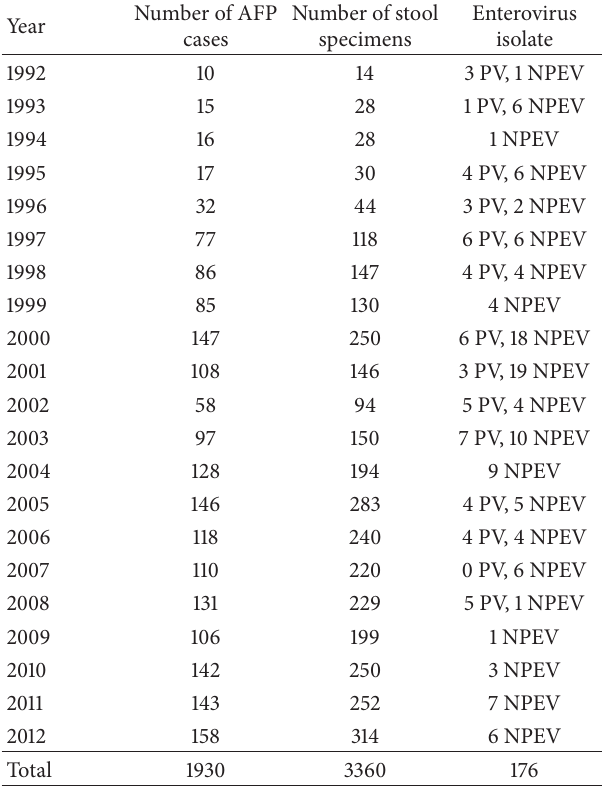
Table 1: AFP isolates between 1992 and July